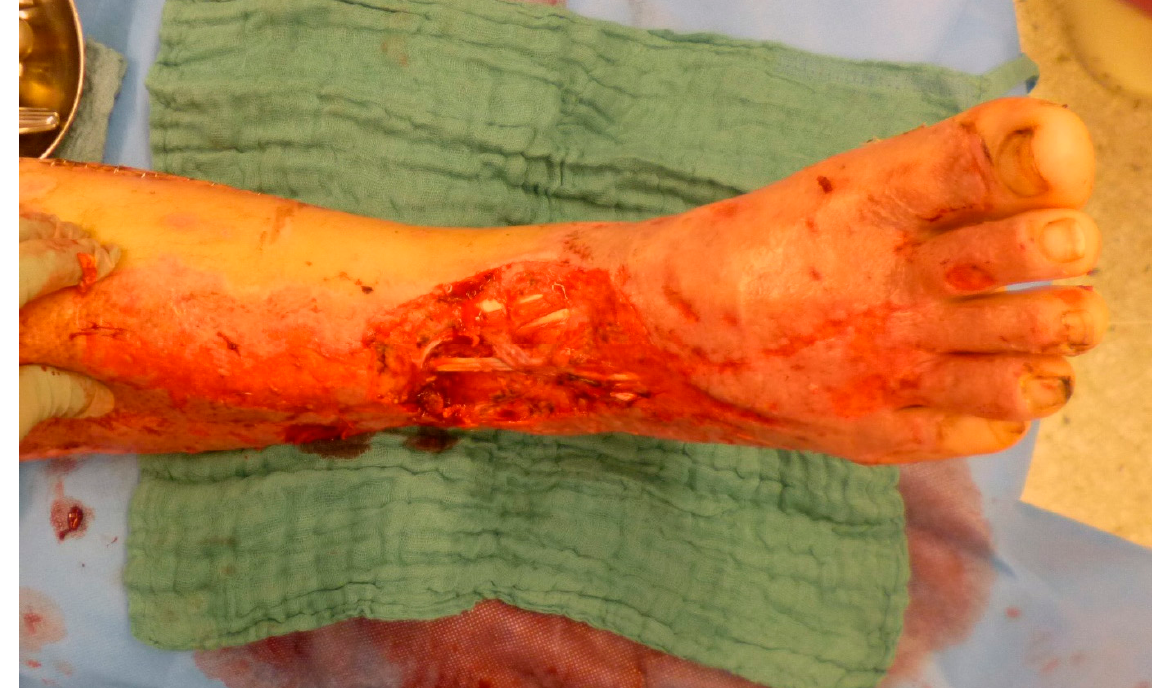
Figure 1. Full-thickness defect after failed STSG due to diminished perfusion of the wound bed in a patient suffering from high-voltage trauma.